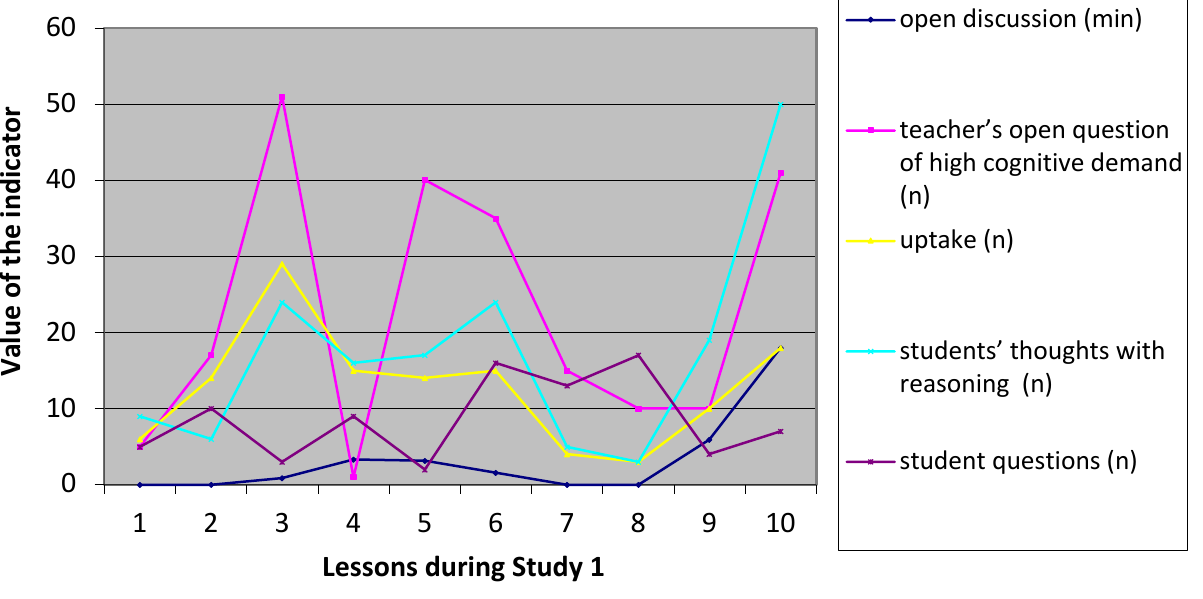
Figure 2: Development of dialogic indicators during Study 1 (November 2014 – May